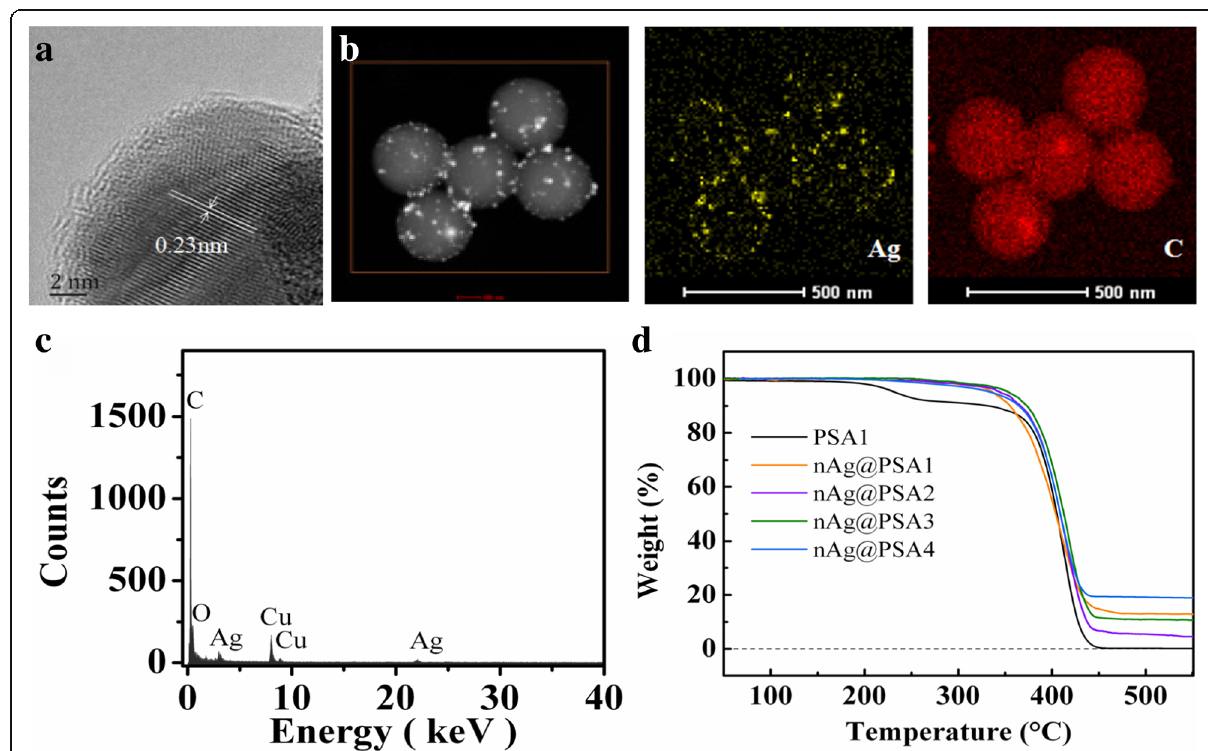
Fig. 7 a HRTEM image of Ag on PSA4 nanospheres. b EDX mapping of nAg@PSA4 composite nanospheres. c EDX spectrum of nAg@PSA4